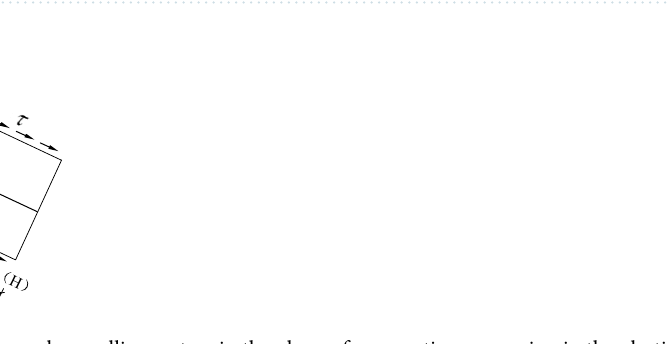
Figure 5. Force diagram of the anchor-pulling system in the phase of compaction-expansion in the plastic zone (expansion of plastic